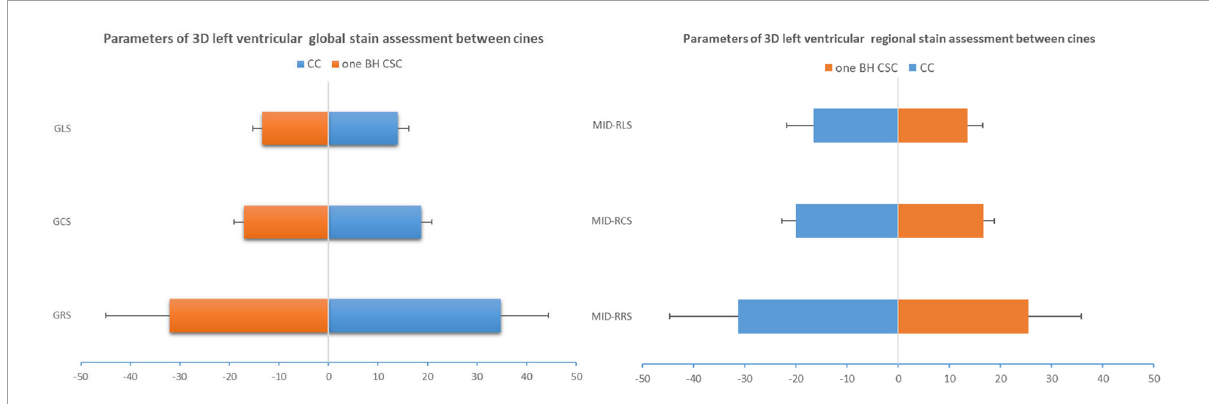
FIGURE3 3D global strain and mid-regional strain computed by CC and one BH CSC protocols. ICCs of GRS, GCS, and GLS were greater than 0.8, and CVs of GCS and GLS were lower than 15%. ICCs were moderate (0.6 < ICC < 0.8) for mid-regional strain, but CVs were more than 15%.